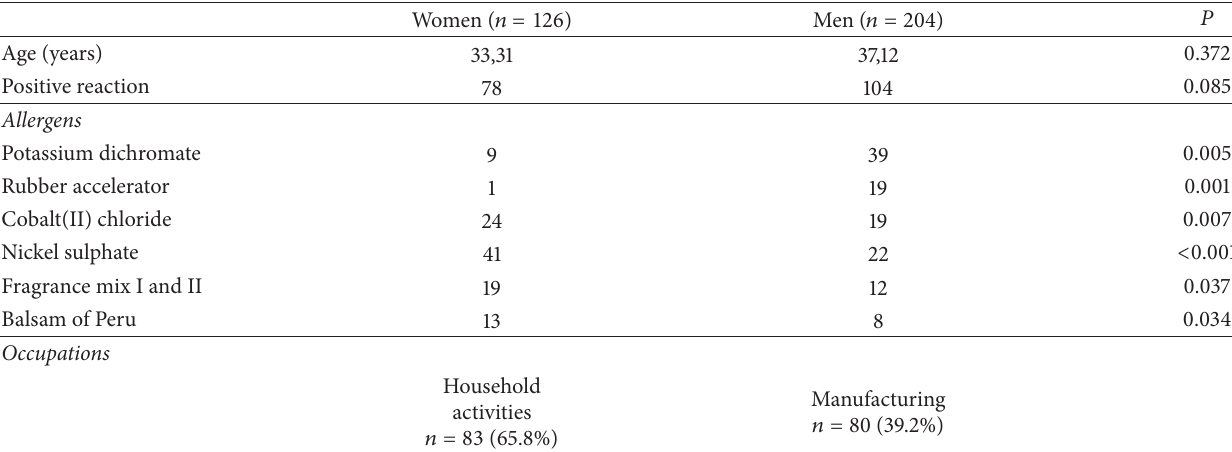
Table 1: Comparison of patch test results of men and